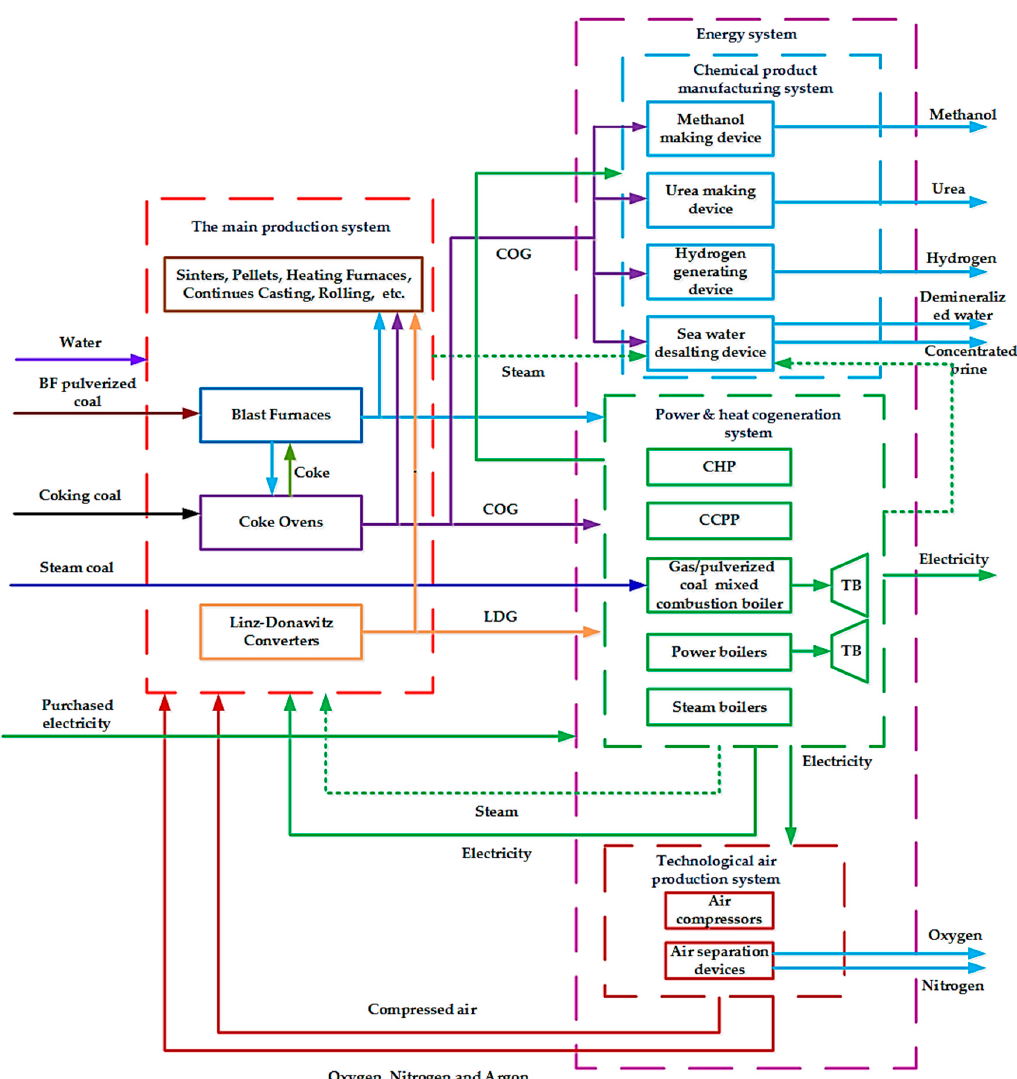
Figure 1. Schematic flow of an iron and steel enterprise energy system.